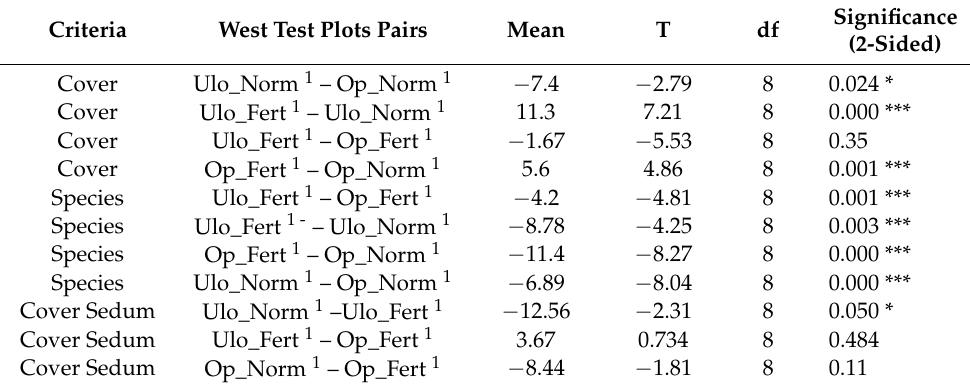
Table 13. Greening with turf mats, n = 9 years, from 2011 to 2020 (df 8), coverage and number of species for the test plots with fertilizer (Fert.) and without (Norm) of the western position. Pairwise t -test and the different level of significance. The significance indicate the effects of fertilizer on the cover values, negative sign, indicate reduction of the values over the years.